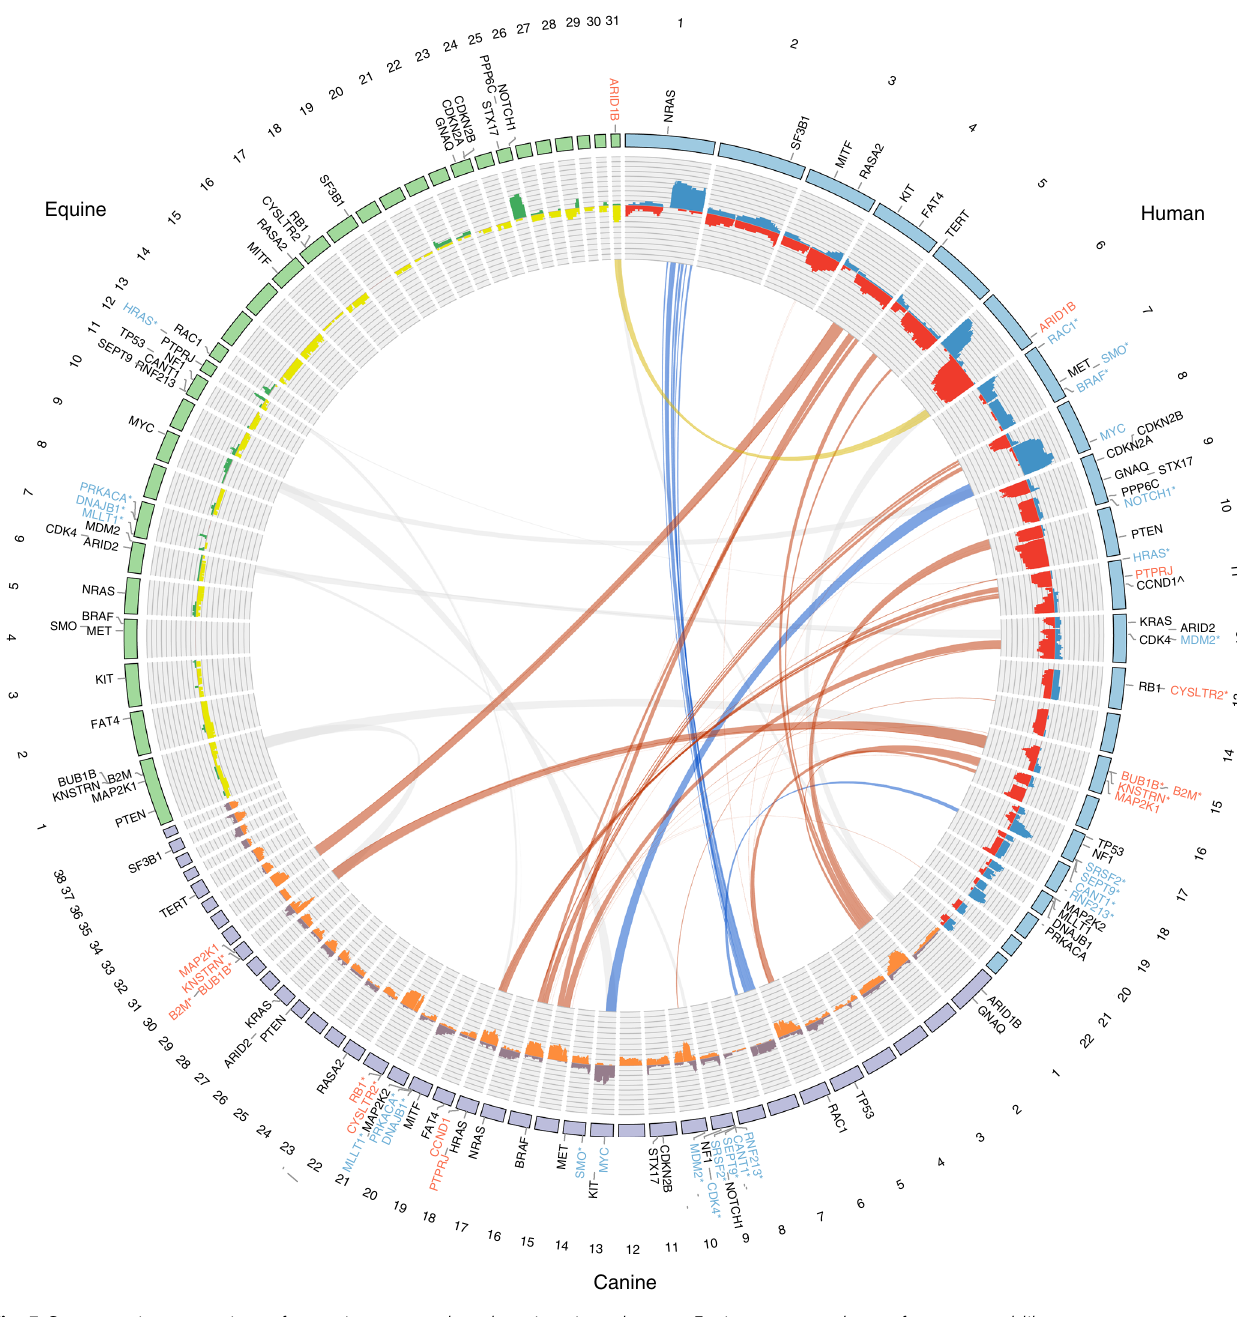
Fig. 5 Cross-species comparison of somatic copy number alterations in melanoma. Equine cases used were from mucosal-like or mucocutaneous sites. Chromosomes are represented by the outer track. Genes shown are established or candidate melanoma genes. The histogram shows the frequencies of copy number (CN) gains (blue, purple, green) and losses (red, orange, yellow) in each species. The blue ribbons indicate regions of synteny on canine chromosomes and human chromosome arms that have a median frequency of CN gain of at least 0.2 in both species. Similarly, the orange and yellow ribbons indicate syntenic regions on canine and human chromosomes/arms, and on equine and human chromosomes/arms, respectively, with a median frequency of CN loss of at least 0.2 in both species. Gray ribbons show syntenic regions where the frequency of CN gain or loss was below 0.2. Genes shown in blue or red with an asterisk (*) are located within a signi fi cant focal CN gain or loss, respectively. The remaining genes in blue or red are located on chromosomes/arms in syntenic regions linked by blue or orange/yellow ribbons, respectively. ^ CCND1 is on human chromosome 11, which had a frequency of CN loss>0.2, however, this gene is in focally ampli fi ed region from GISTIC 2.0 analysis with q -value = 0.11 (Supplementary Data